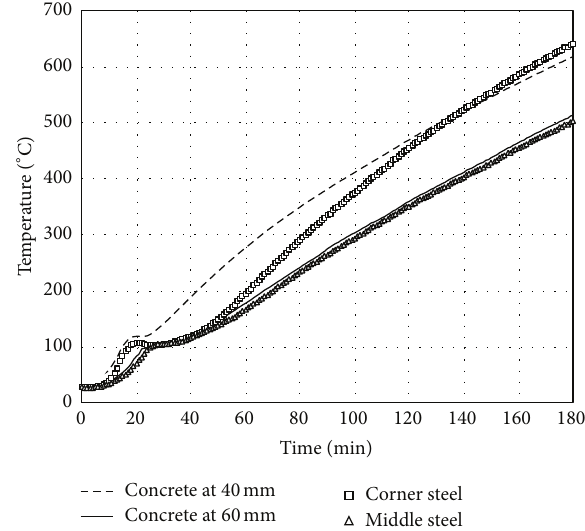
Figure 7: Comparison between temperature evolution in concrete and steel.